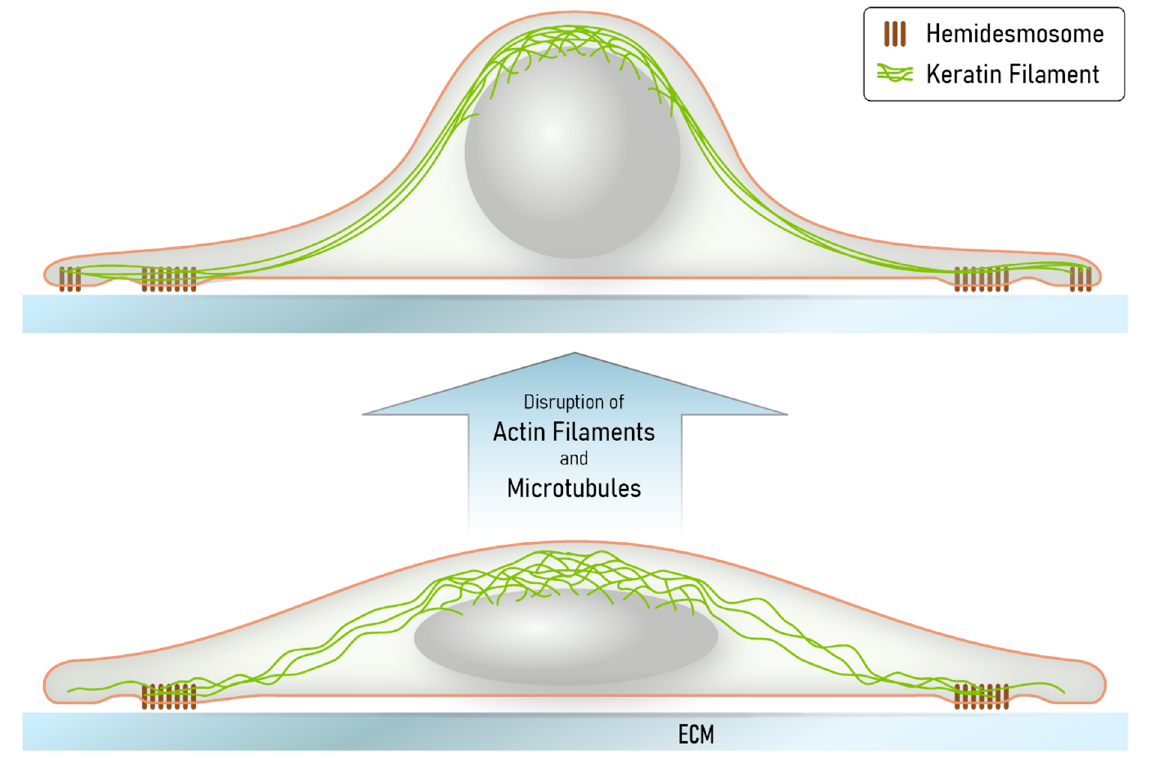
Figure 8. The scheme summarizes our major findings and illustrates how the keratin network may provide mechanical resilience to extreme cellular deformation, leading to network reorganization through filament bundling and filament nucleation at nascent hemidesmosomes. Disruption of both the actin filament and microtubule systems induces cell shape changes because of loss of cortical actomyosin contractility and altered intracellular stiffness. Together, these changes are predicted to lead to a rounding of the nucleus and the surrounding cell body, which is counterbalanced by the keratin intermediate filament cytoskeleton. Since the hemidesmosome-anchored keratin filament network persists, radial filaments become stretched, losing their waviness and forming thick bundles. Localized hemidesmosome formation and keratin filament nucleation allows adjustment of the remaining cytoskeleton to cell shape. We propose that deformations, which may, for example, occur in migrating cells after wounding or in epidermal cell layers subjected to tensile stress and viscous shear stress, elicit comparable responses in the superelastic keratin intermediate filament network.